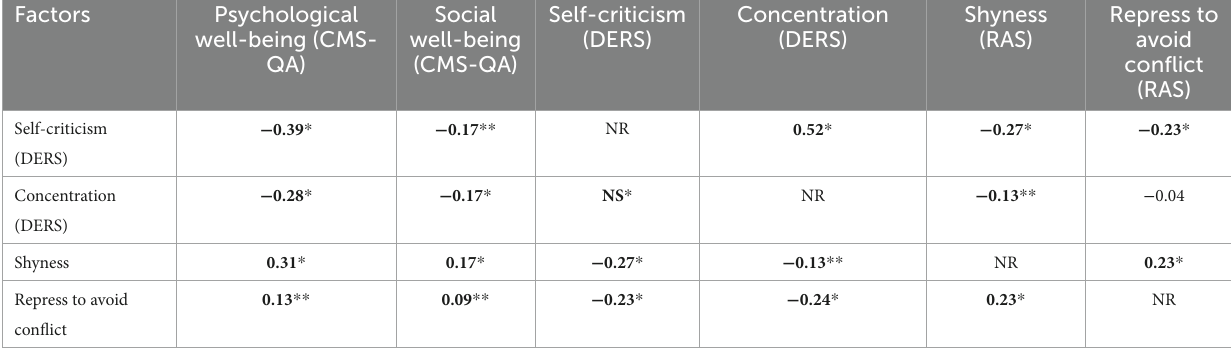
TABLE 6 Correlations and p values for well-being, self-criticism, concentration, shyness, and repressed emotions.